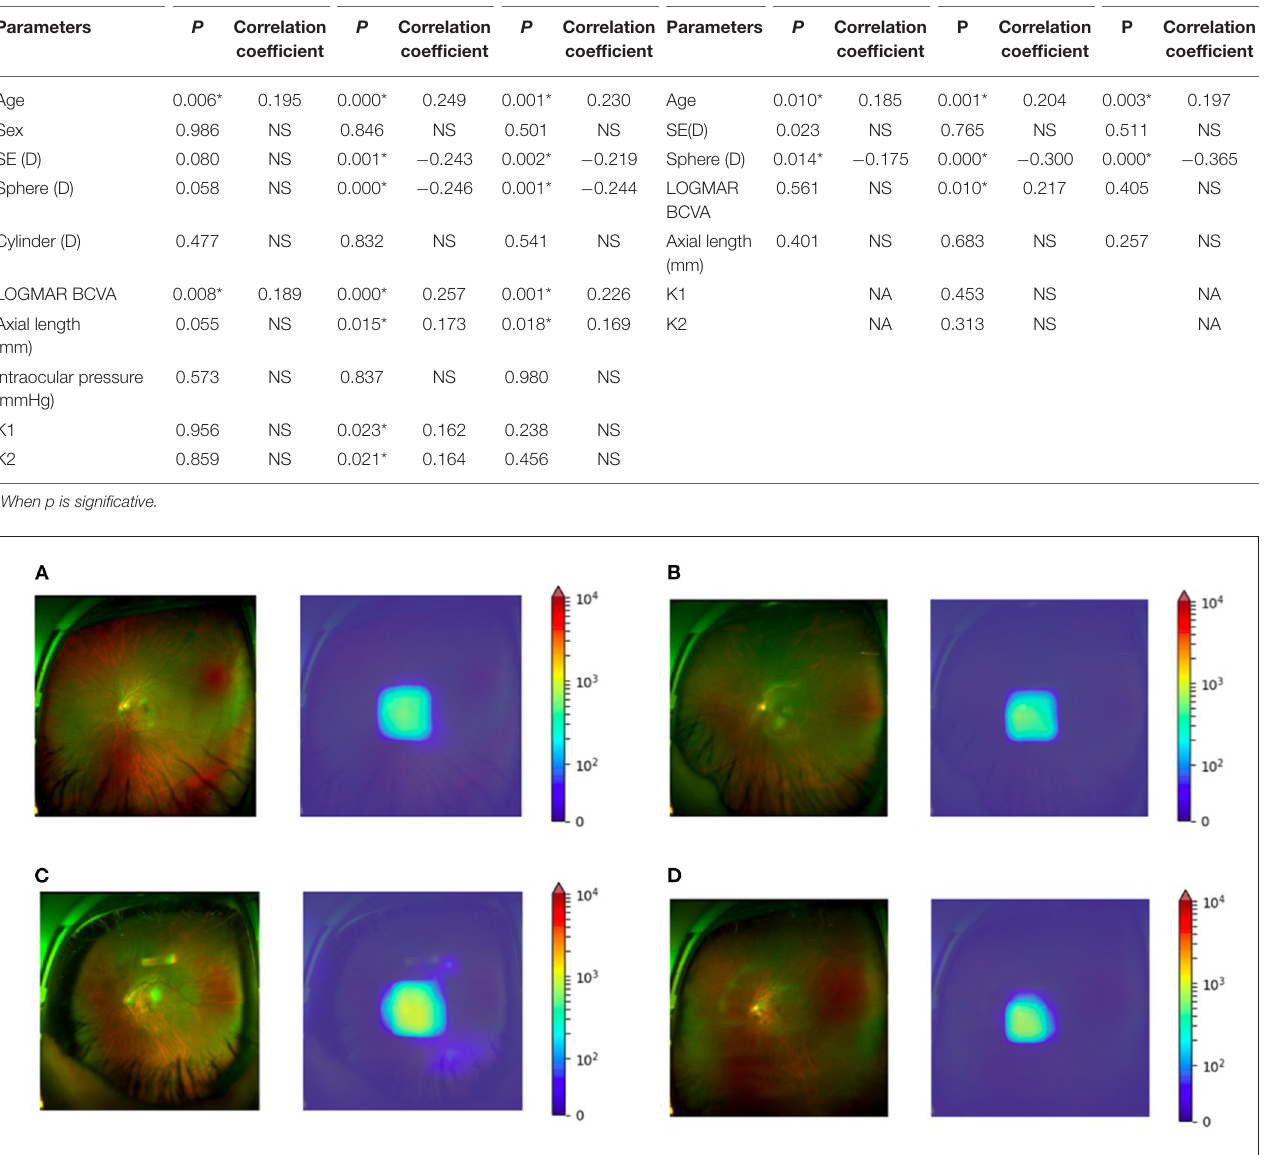
FIGURE 4 | Weighted heat map for four myopic eyes SE between − 6.00D to − 12.00D. (A) Subjective refraction of − 8.50D with the predicted value of − 8.37D. (B) Subjective refraction of − 9.13D with the predicted value of − 8.89D. (C) Subjective refraction of − 10.63D with the predicted value of − 10.52D. (D) Subjective refraction of − 12.00D with the predicted value of −